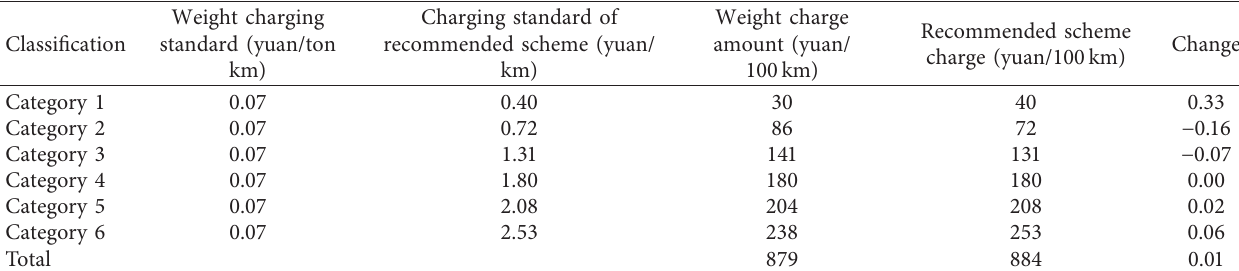
Table 11: Comparison of new and old freight